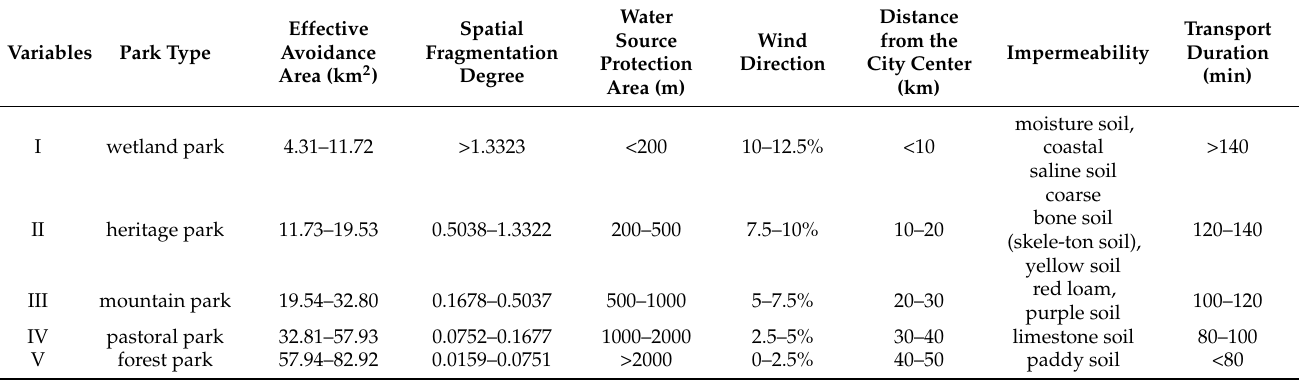
Table 7. Grading criteria for influencing factors.